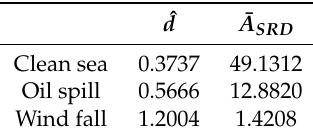
Table 2. Classification parameters for Ionian Sea dataset.